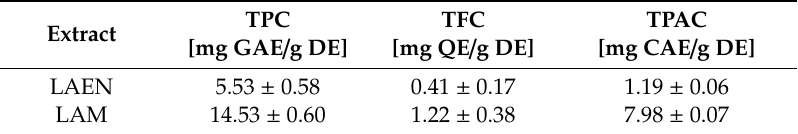
Table 3. The total phenolic (TPC) and total flavonoid (TFC) content in the etheric (LAEN) and methanolic (LAM) extracts from L. krap ffi i fruits. The results are expressed as mg of gallic acid equivalent (GAE) and quercetin equivalent (QE) per 1 g of dry extract (DE). Values are presented in mean ± SEM, n =